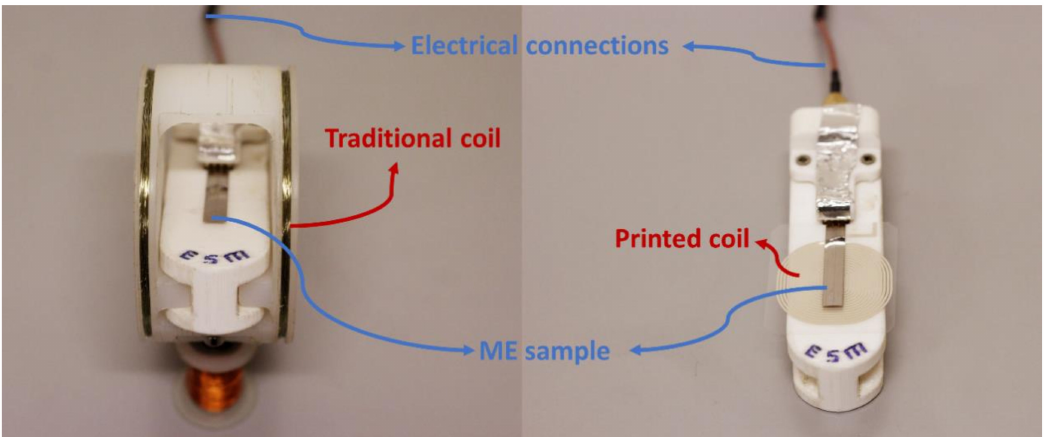
Figure 1. ME sample placed on a traditional coil (left) and on the top a printed coil